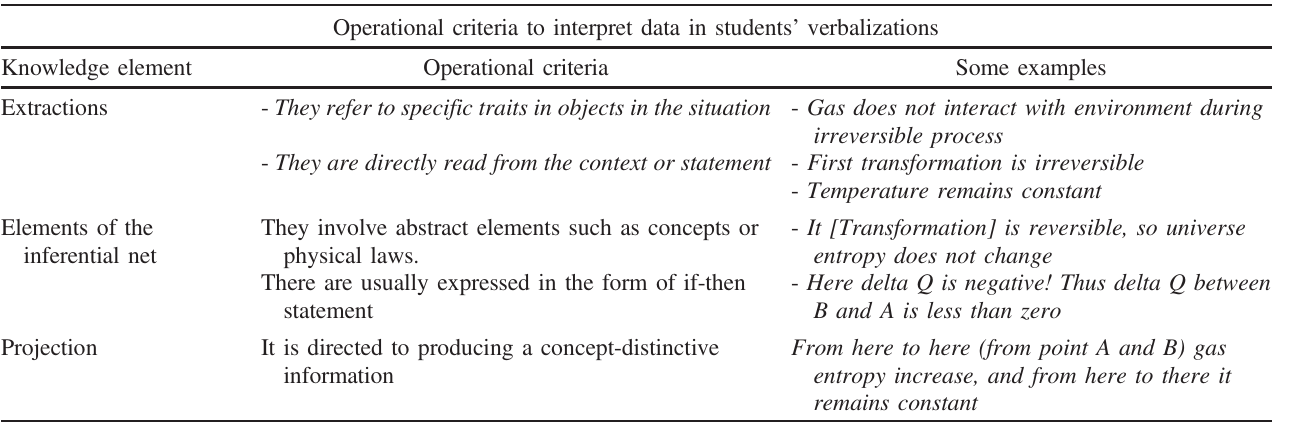
TABLE I. Operational definitions for extractions, elements of the inferential net, and